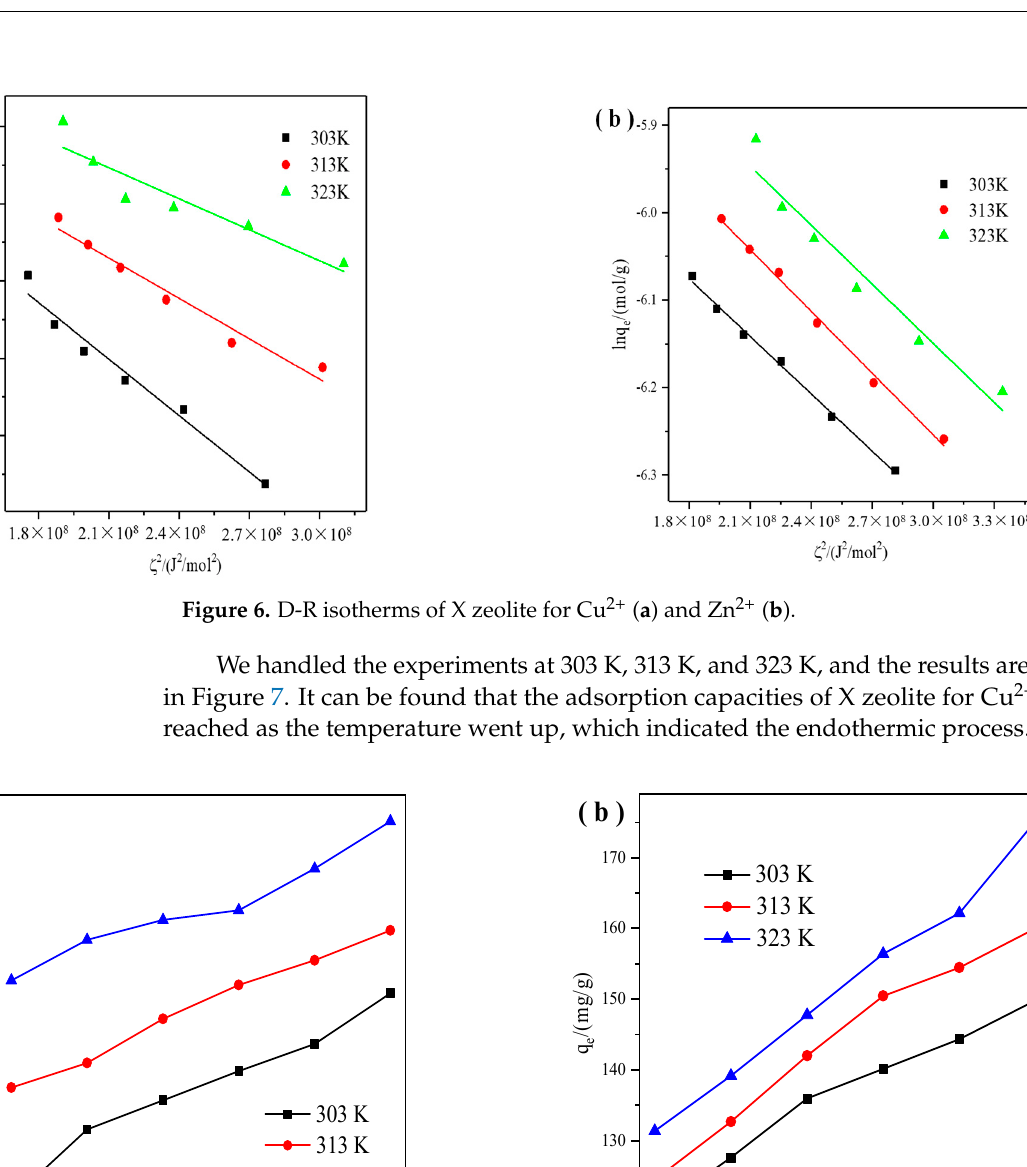
Figure 7. Adsorption isotherms of X zeolite for Cu 2+ ( a ) and Zn 2+ ( b ).